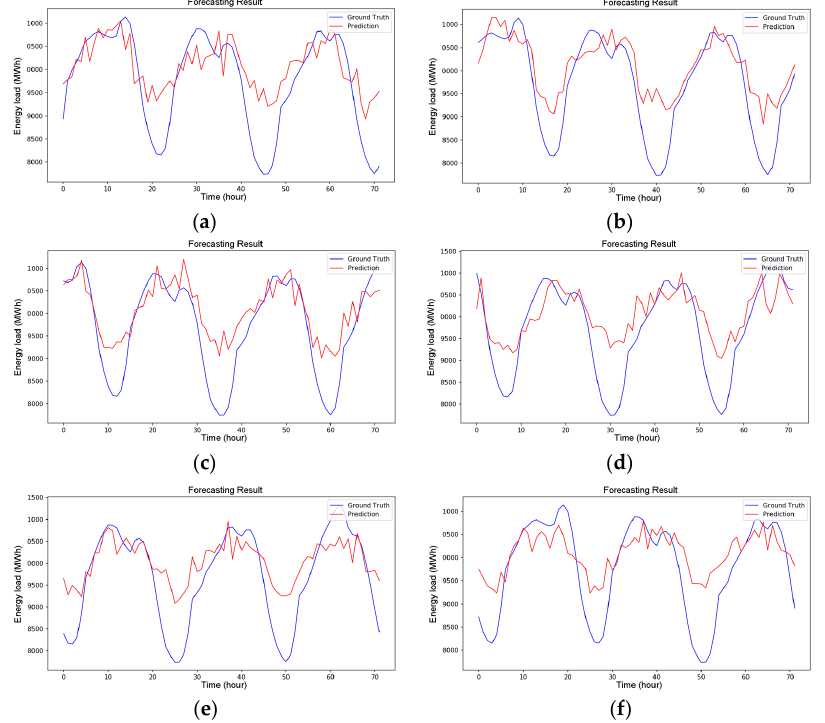
Figure 8. The forecasting results of decision tree (DT): ( a ) Partial results A; ( b ) Partial results B; ( c ) Partial results C; ( d ) Partial results D; ( e ) Partial results E; ( f ) Partial results F.